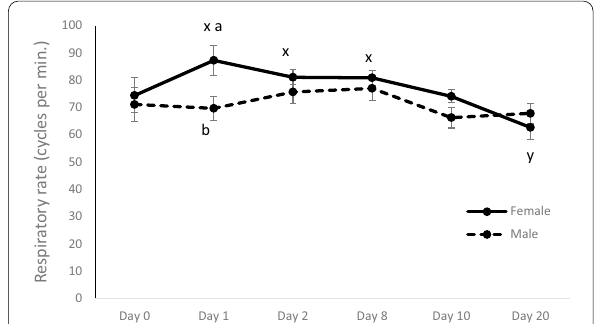
Fig. 4 Changes in morning respiratory rate of neonatal buck-kids and doelings from birth to Day 20. Values with a , b and x , y indicate significant different ( P < 0.05) between different sexes and ages, respectively